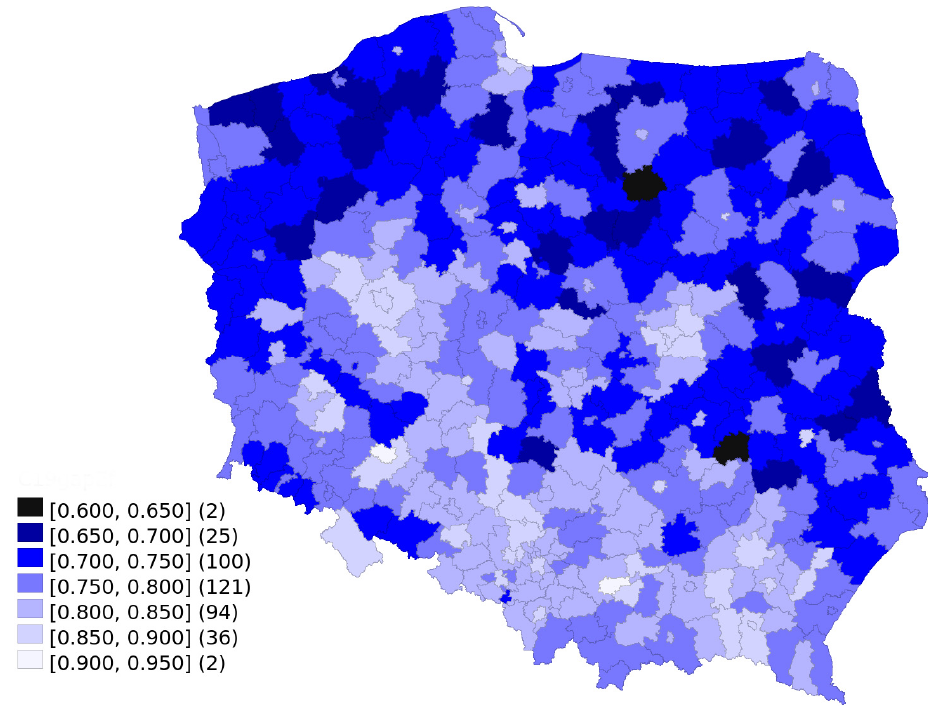
Figure 3. Male to female ratio of COVID-19 detection among the working-age (25–54 years) population of Poland for the period 1 January 2021 to 21 March 2022, corrected for gender imbalance.